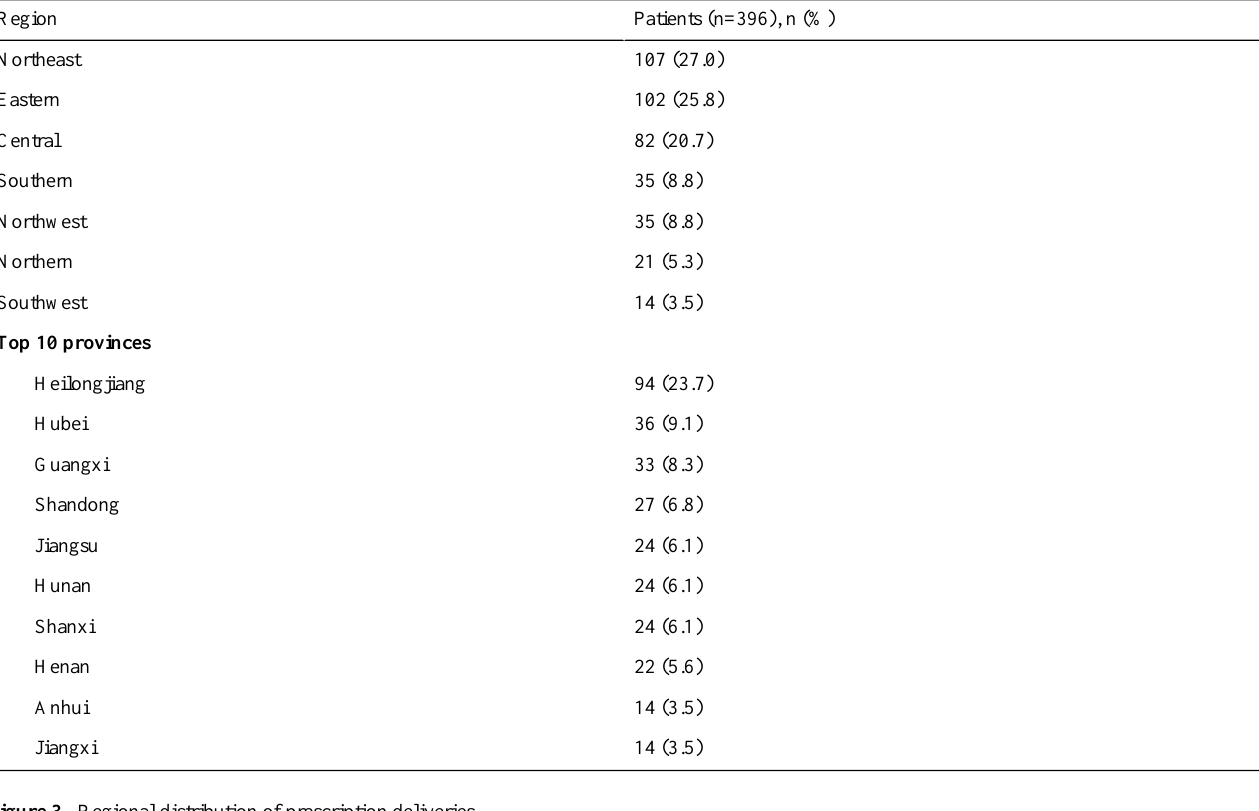
Table 3. Out-of-province delivery details based on the geographical regions of China.